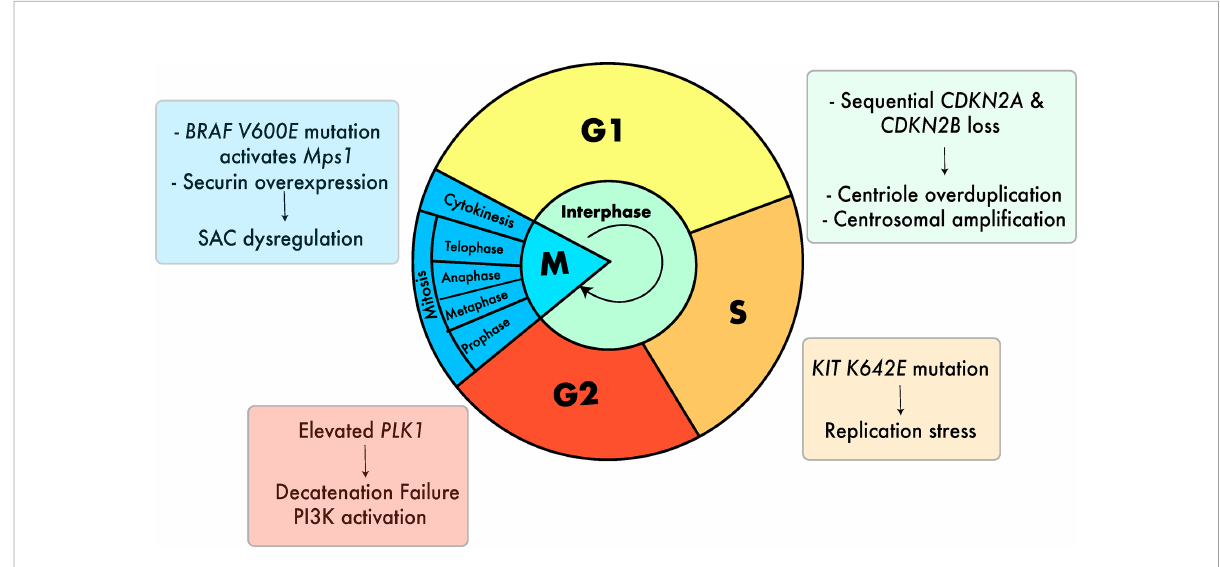
FIGURE 3 Cell cycle defects that can lead to aneuploidy in melanoma. Defects include centrosomal ampli fi cation (29, 81, 82), replication stress (28), G2 decatenation failure (83 – 85) and SAC dysregulation (26). (27, 86). Colors of the boxes containing text are associated with the color of the respective stage of the cell